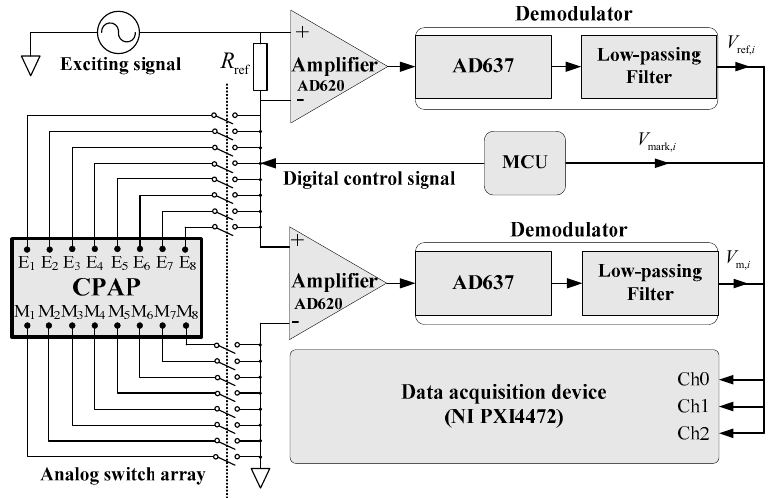
Figure 4. The sketch of the CPAP measure system.